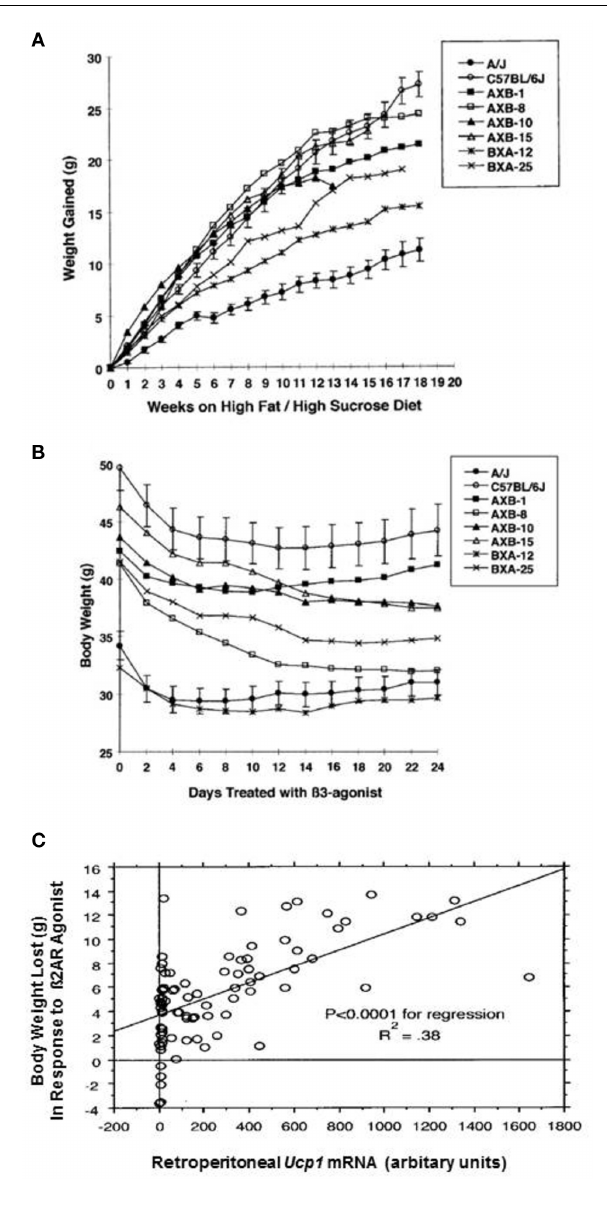
FIGURE 3 | (A) Body weight gained by parental and RI strains fed a high fat/high sucrose diet (Research Diets 12331) starting at 7week of age and continuing for 18week. (B) After 18week, mice continued to be fed the high fat/high sucrose diet and were also treated with the β 3-adrenergic agonist, CL 316,243, as described (Guerra et al., 1998). Changes in body weight are shown.The mean ± SE for the B6 and A/J parental strains are shown, whereas only the means have been plotted for the RI stains.The number of mice in each group ranges from 9 to 12. (C) Regression analysis to evaluate the effects of Ucp1 mRNA in the retroperitoneal fat on body weight loss. P is an estimator of the significance of the regression. R 2 is the coefficient of determination; it is the proportion of the dependent variable that is explained by the independent variable. N was